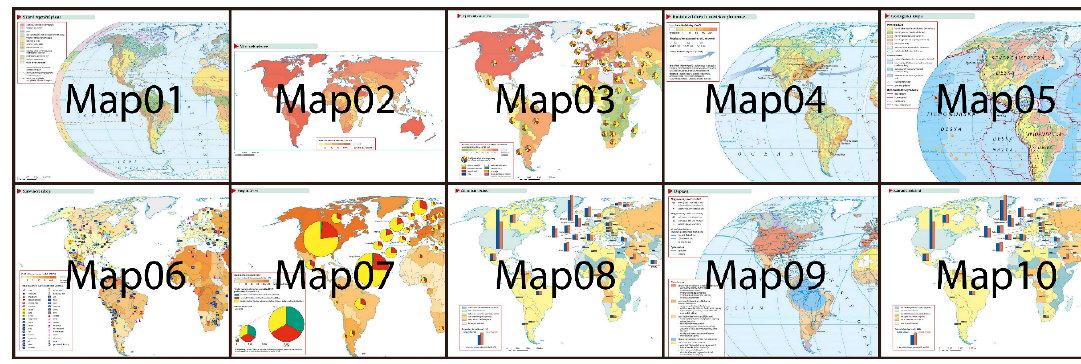
Figure 2 . Map stimuli used in the experiment’s tasks. Figure 2. Map stimuli used in the experiment’s